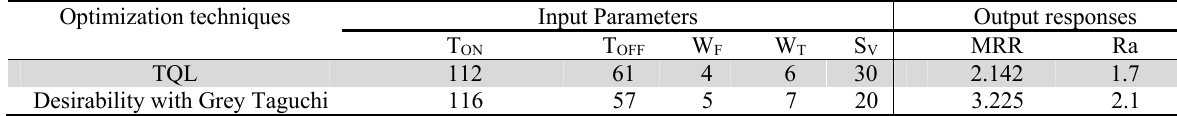
Comparision of output responses Optimization techniques Input Parameters Output responses T ON Desirability with Grey